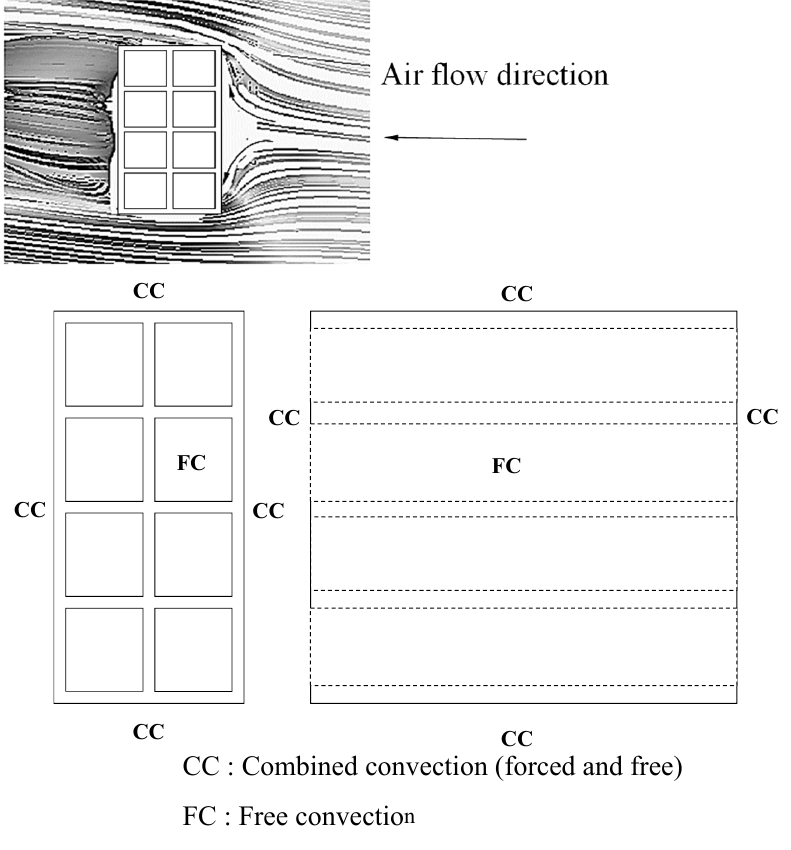
Figure 3. Brick with side facing the air flow.